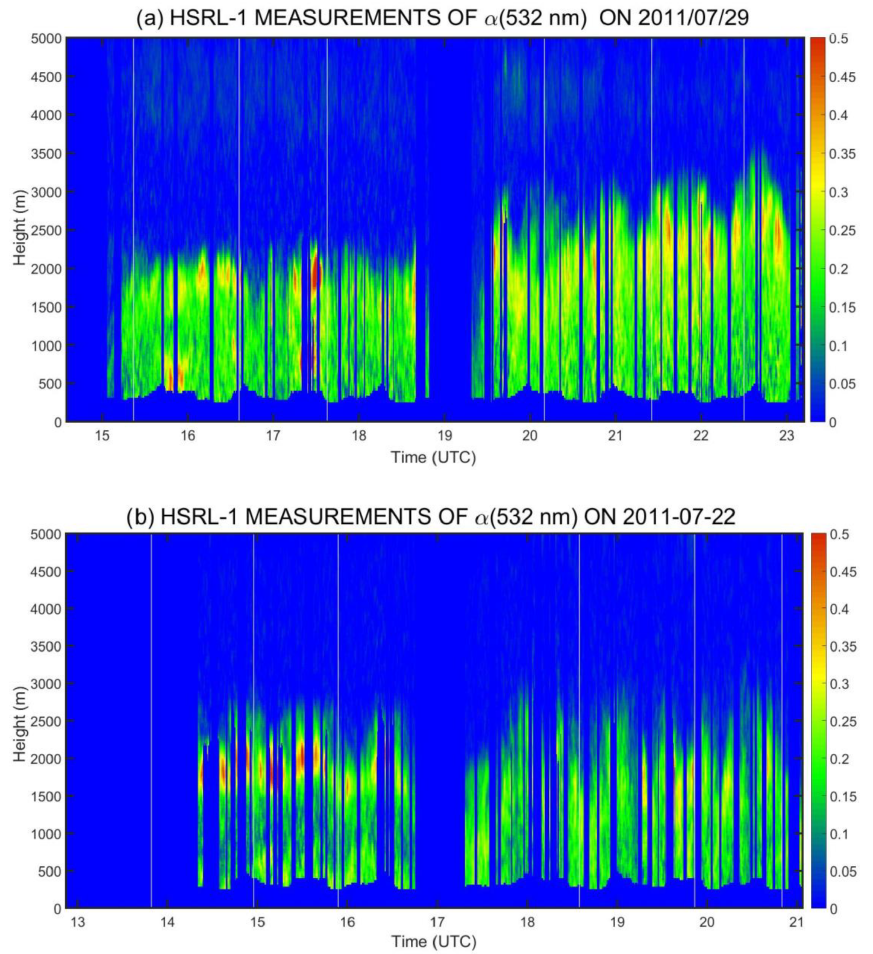
Figure 10. Temporal evolution of aerosol extinction coefficient ( α ) at 532nm obtained by the HSRL-1 system over the Baltimore–Washington DC area on (a) 29 July 2011 and (b) 22 July 2011. Vertical white lines represents times when the system flew over NASA Goddard Space Flight